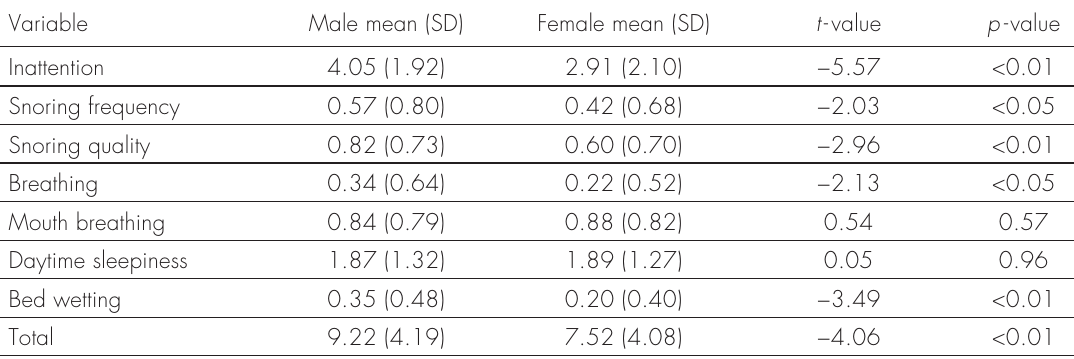
Table III. Association between gender and risk